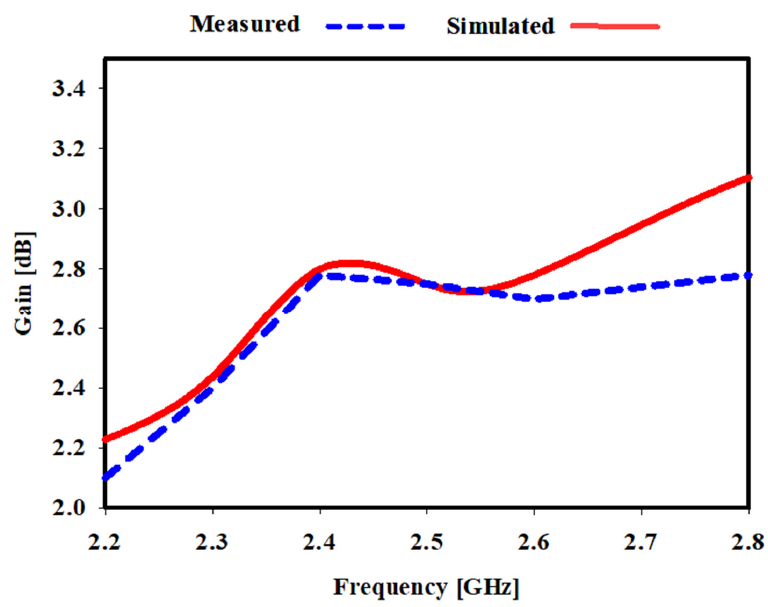
Figure 9. Simulated and measured gain for a monopole array antenna.